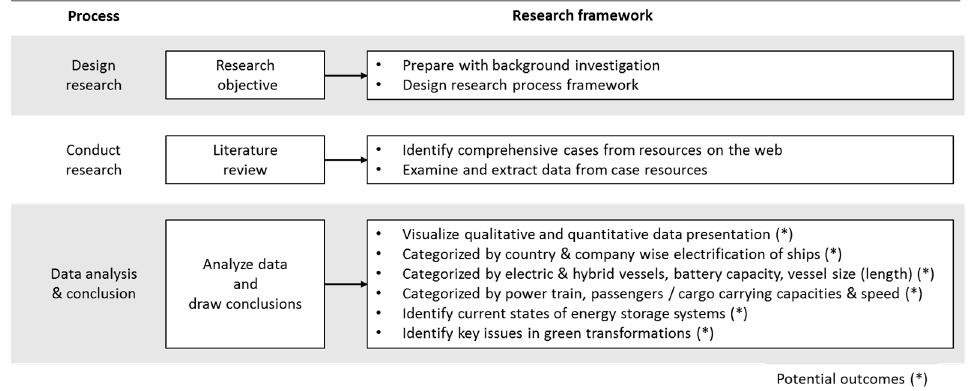
Figure 2. Research framework model.